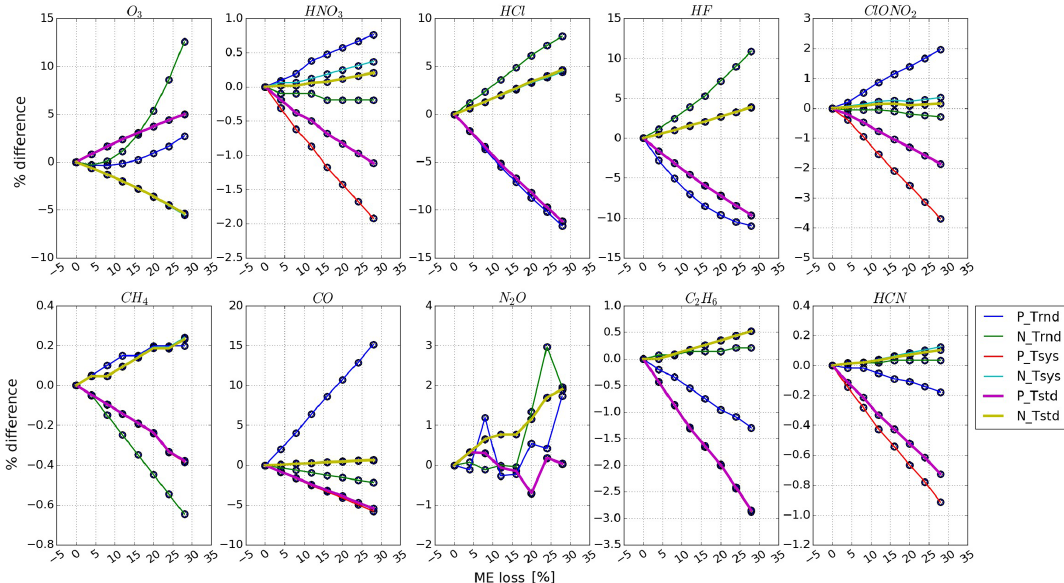
Figure 16. The same as Fig.14 but for the total random uncertainty, the total systematic uncertainty, and the total uncertainty. The acronyms in the legend are similar to those in Fig. 14. “Trnd”, “Tsys”, and “Tstd” represent the total random uncertainty, the total systematic uncertainty, and the total uncertainty, respectively.